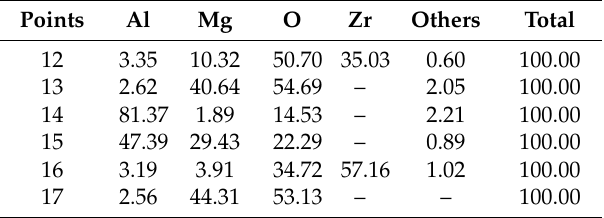
Figure 9. Corrosion morphologies of the Al/Zr/Mg joint in the 3.5% NaCl solution for 4 h: ( a ) overview and ( b – e ) magnified views of the R9, R10, R11, and R12, respectively. Table 6. Elemental compositions (in wt.%) of points 12–17 in Figure 9b–e.